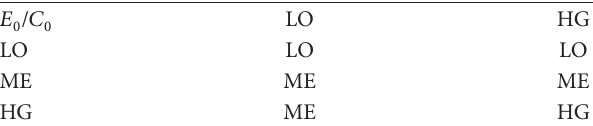
Table 1: The fuzzy rule